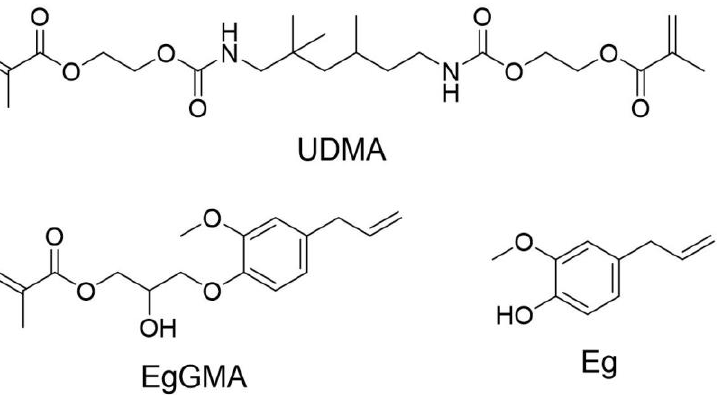
Figure 1. Chemical structures of urethane dimethacrylate (UDMA), eugenyl glycidyl methacrylate (EgGMA), and eugenol (Eg). Table 1. Composition of the investigated experimental composites, showing the variation of EgGMA and Eg in the matrix of UDMA.